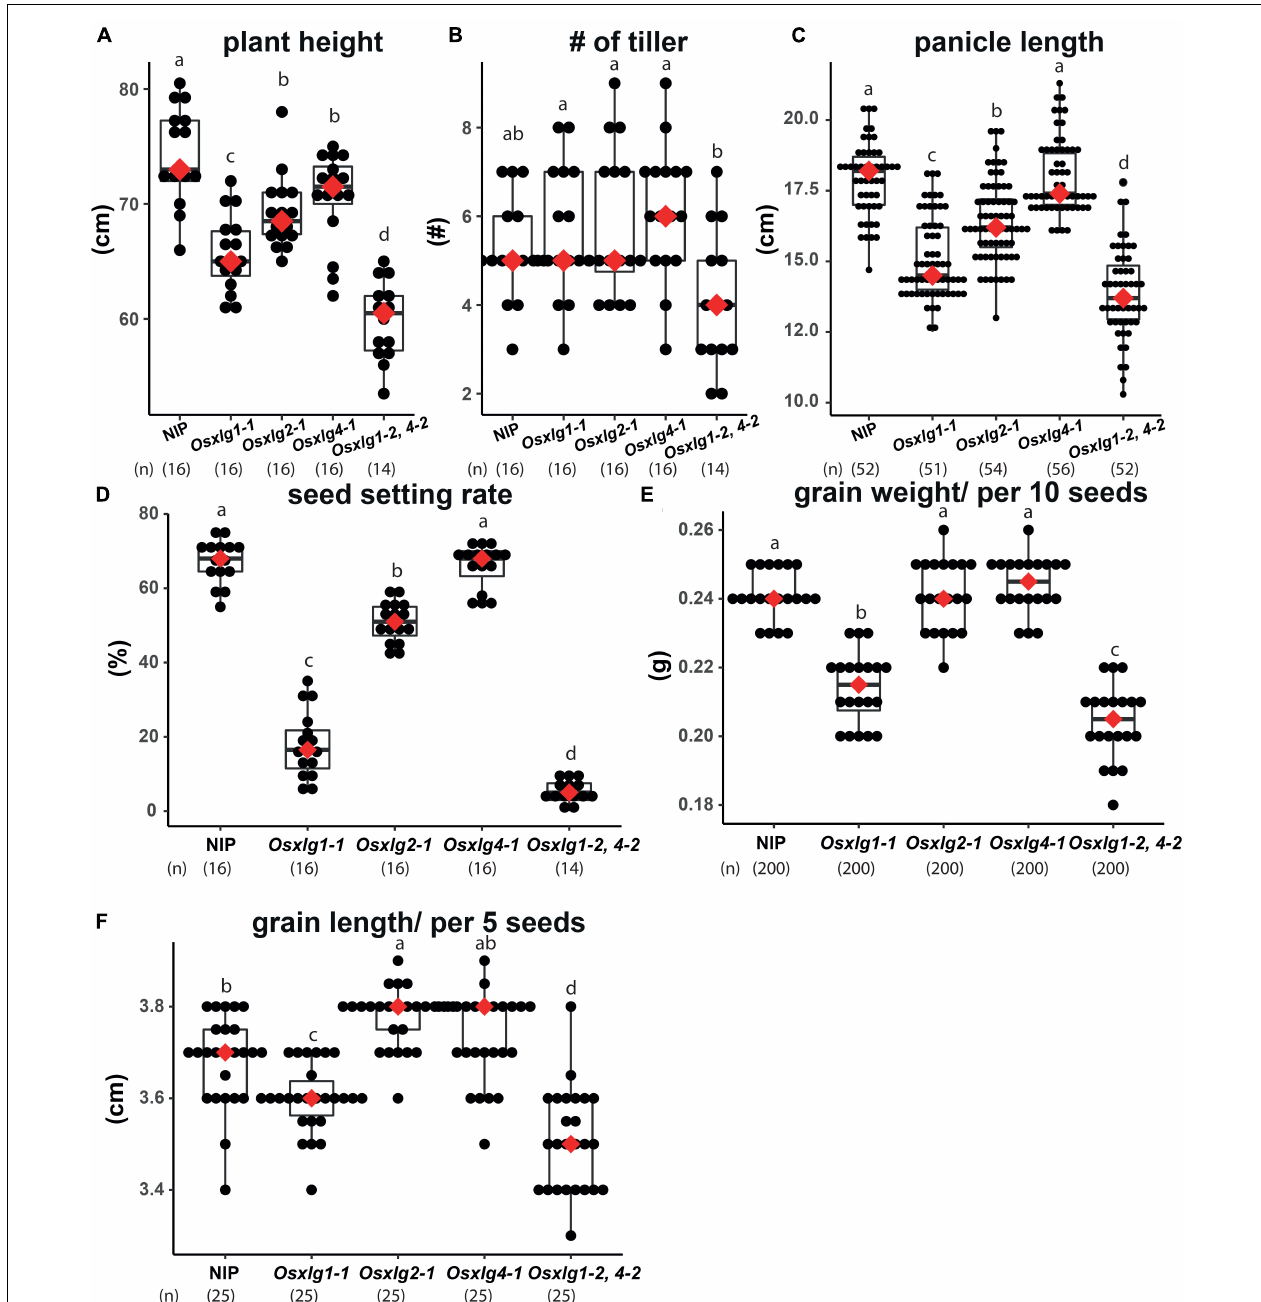
FIGURE 8 | Agronomic traits of Osxlg mutants under tropical greenhouse condition. Basic agronomic traits of Osxlg single ( Osxlg1-1, Osxlg2-1, Osxlg4-1) , double ( Osxlg1-2,4-2 ) mutants, and WT (NIP) plants obtained in greenhouse condition. Plant height (A) , number of tillers (B) , panicle length (C) , seed setting rates (D) , grain weight per 10 seeds (E) , and grain length per five seeds (F) from controls and Osxlg single and double. Box plots showed 1st and 3rd quantile. Red dots represent median. Sample size was shown as ( n ). Significance values are with one-way ANOVA followed by Tukey’s post hoc